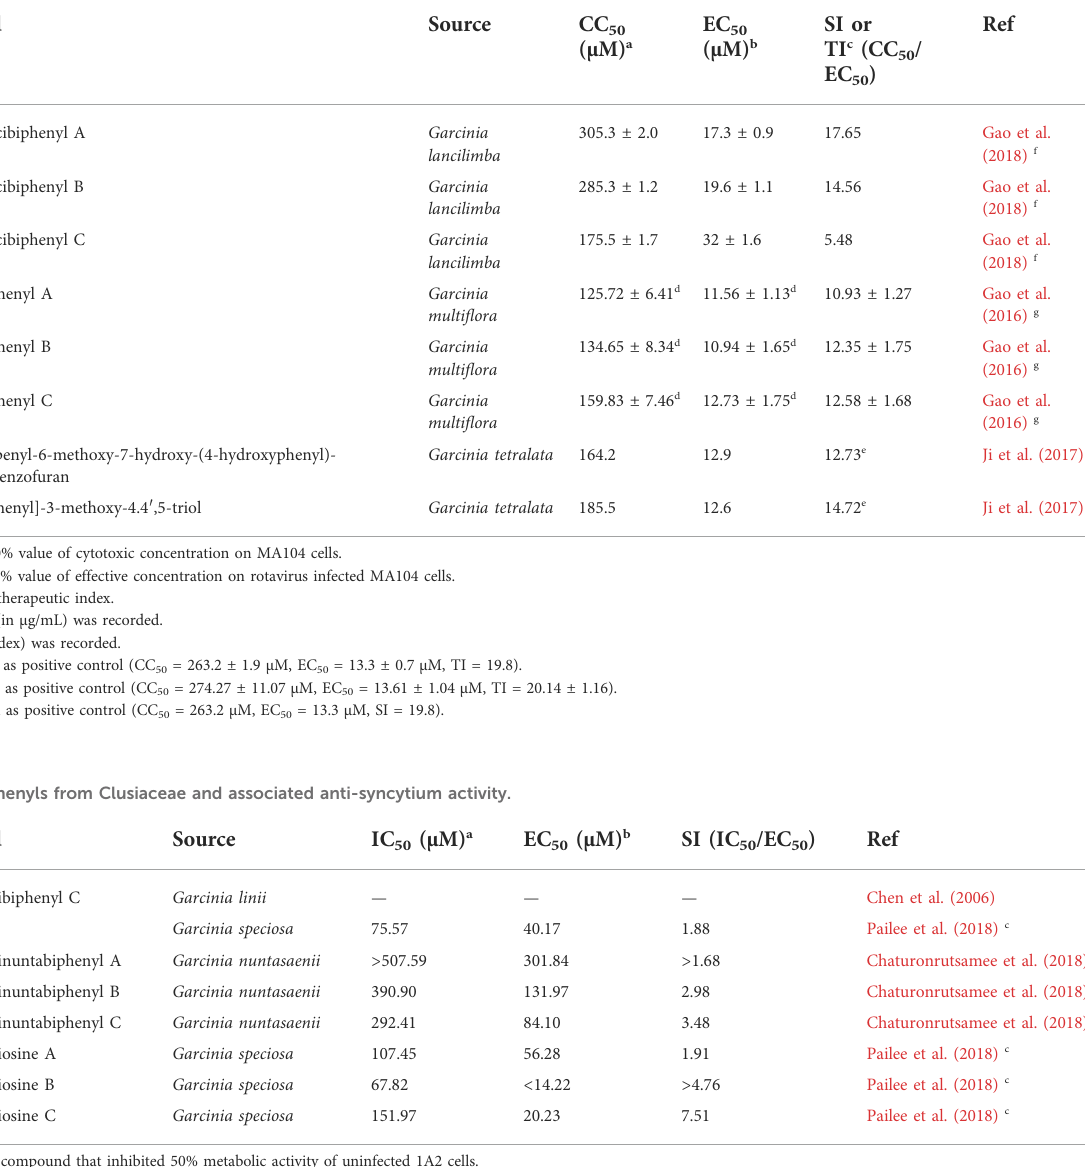
TABLE 4 Biphenyls from Clusiaceae and associated anti-rotavirus activity. Compound